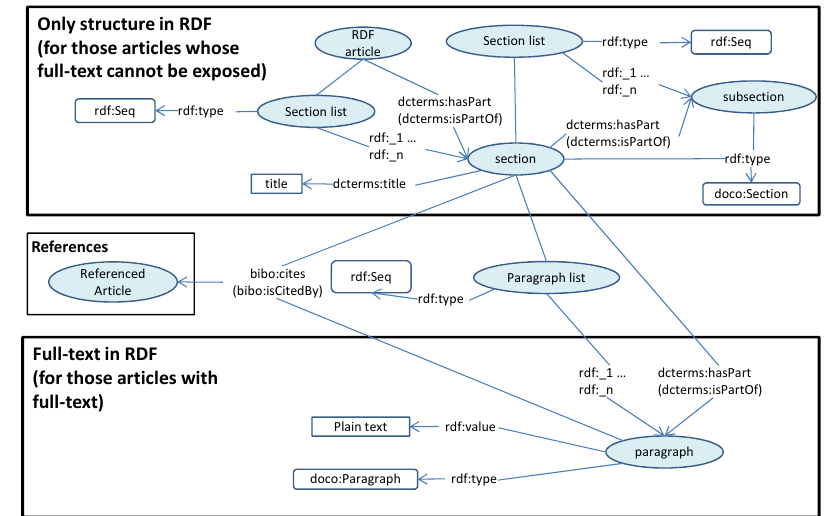
Figure 3. Model used for describing article content and structure. Core concepts in the model are marked in blue. Adapted from